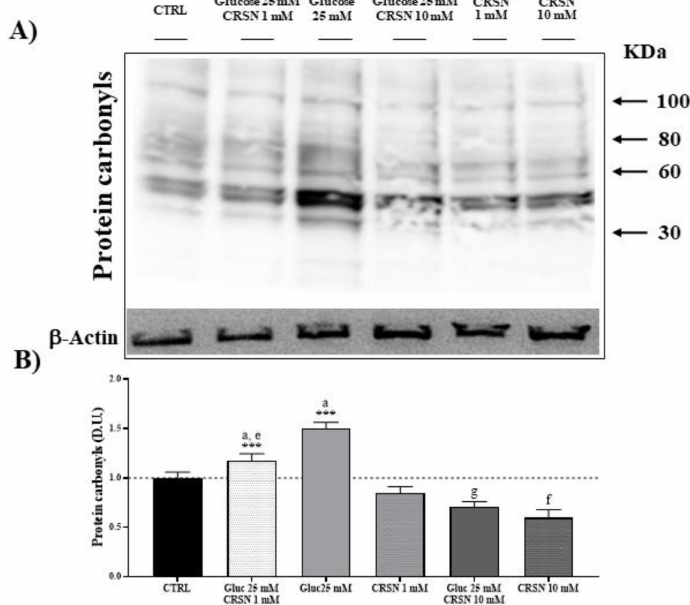
Figure 5. Glucose stress (25 mM) increased total protein carbonylation in murine podocytes, compared to controls by 50% ( p = 1 × 10 − 7 ). Incubation with carnosine (1 mM and 10 mM) significantly